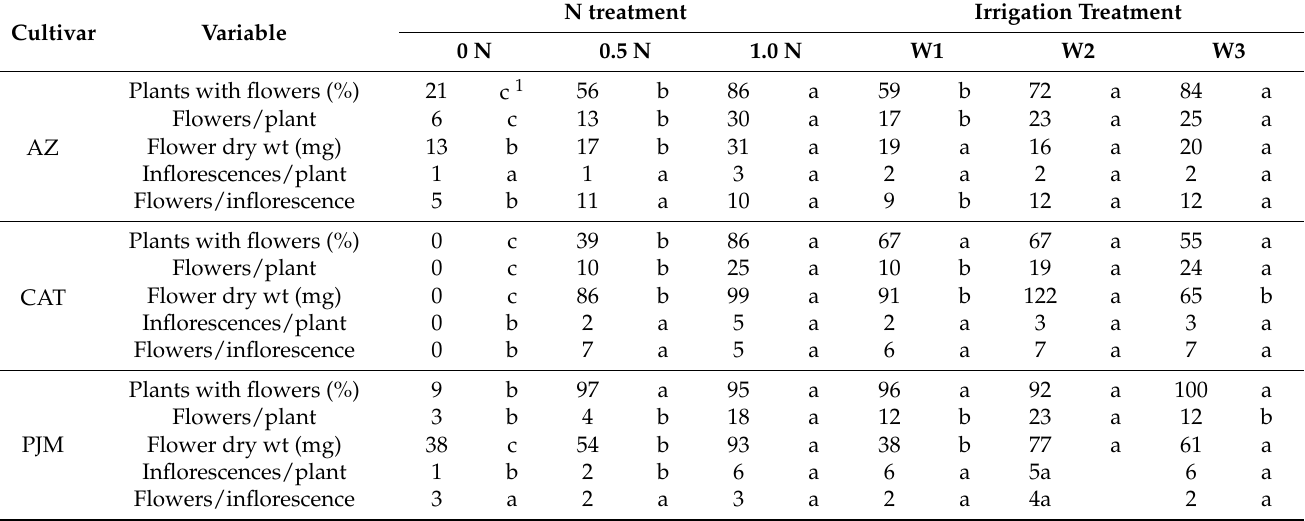
Table 2. Effects of N and irrigation treatments on flowering of ‘Gibraltar’ (AZ), ‘Catawbiense Album’ (CAT), and ‘P.J.M.’ (PJM) Rhododendron . In Year 1, plants were grown in soilless media with